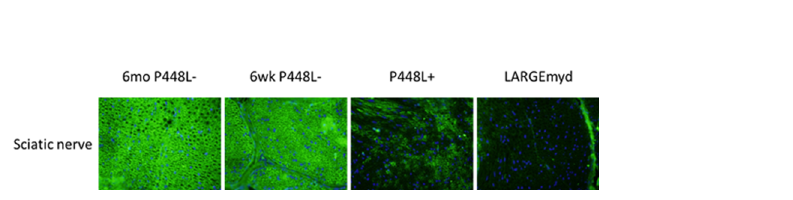
Fig 5. F- α -DG in sciatic nerve. Strong IIH6 staining is demonstrated in the sciatic nerve of 6 week and 6 month old P448Lneo- with patchy expression in the P448Lneo+. Expression surrounding the axons is absent in the LARGE myd . Images are taken at 20X